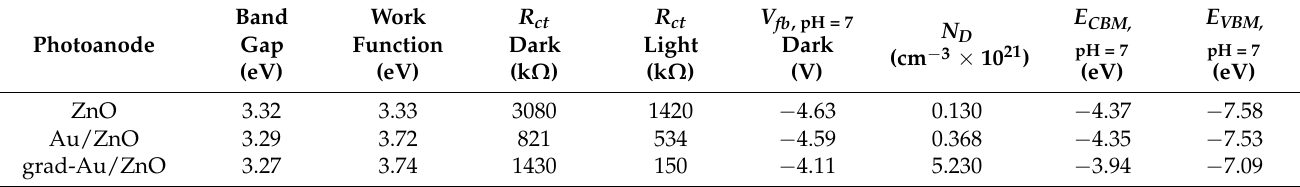
Table 2. Physical properties: flat band potentials and CBM and VBM positions estimated at pH